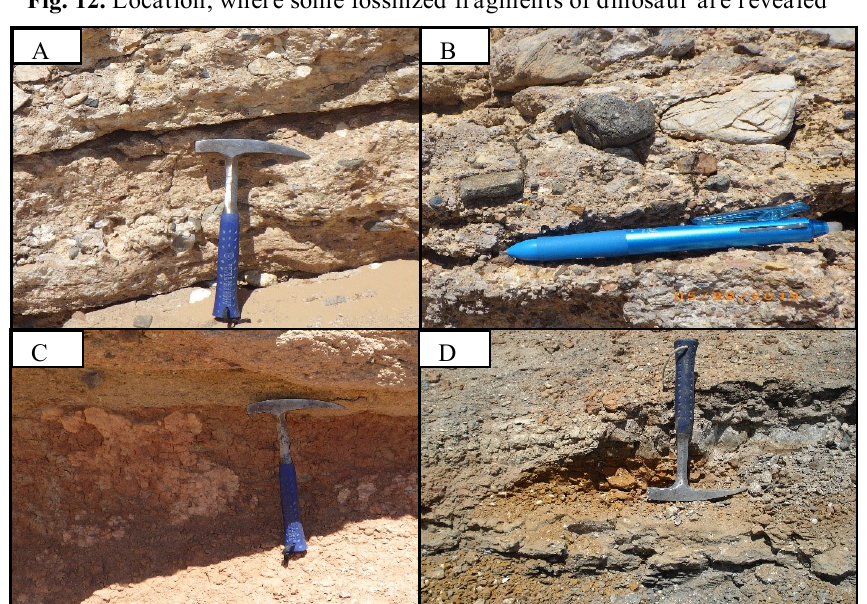
Fig. 13. A and B -shows pebble size conglomerate; C - view of red colored clay beds; D -shows gray, dark gray and yellowish gray massive clay